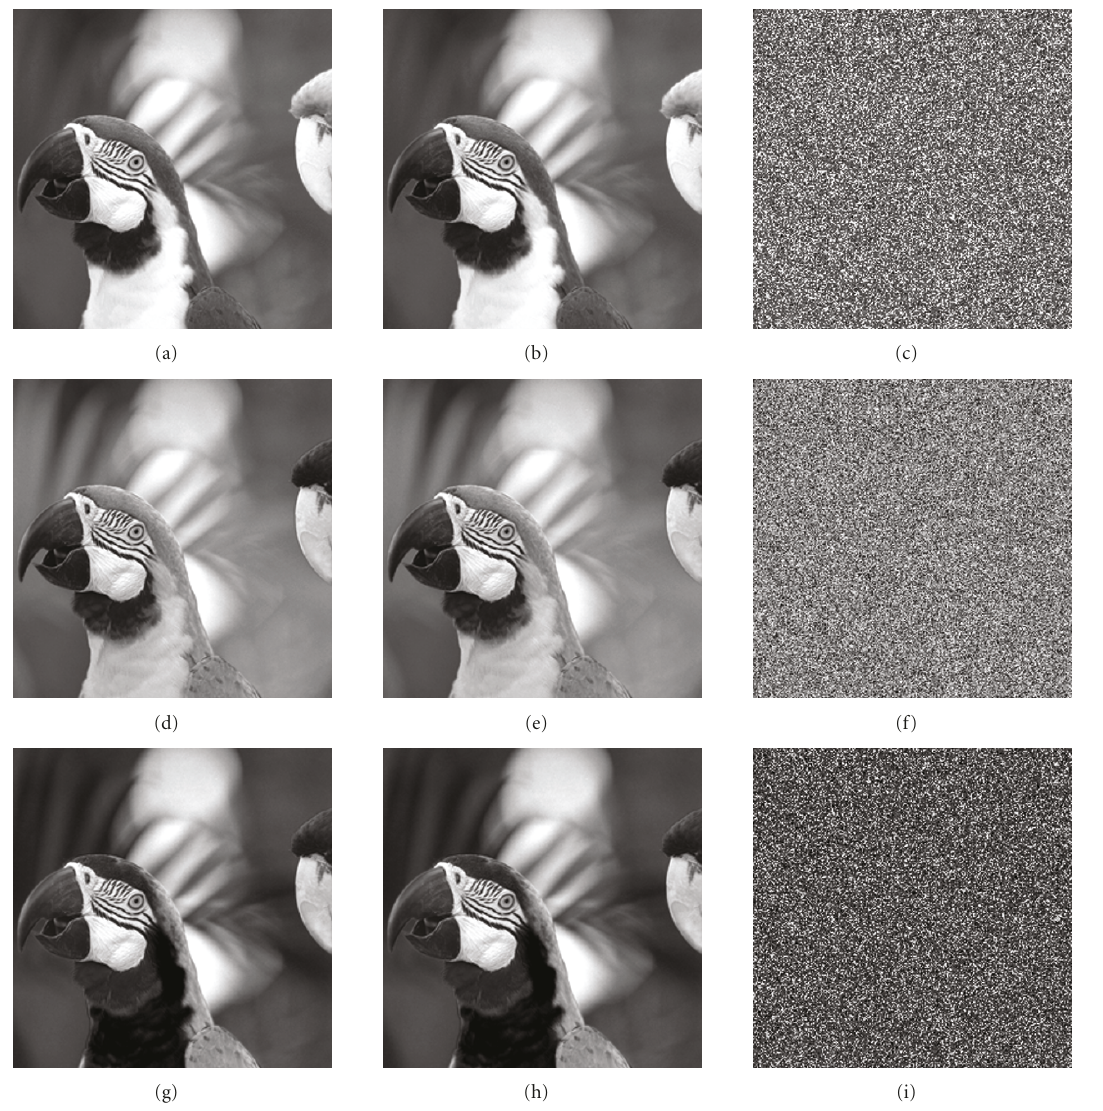
Figure 6: Color components of the Parrot image: original components (a),(d),(g), decrypted-watermarked components (b),(e),(h), and encrypted-watermarked components